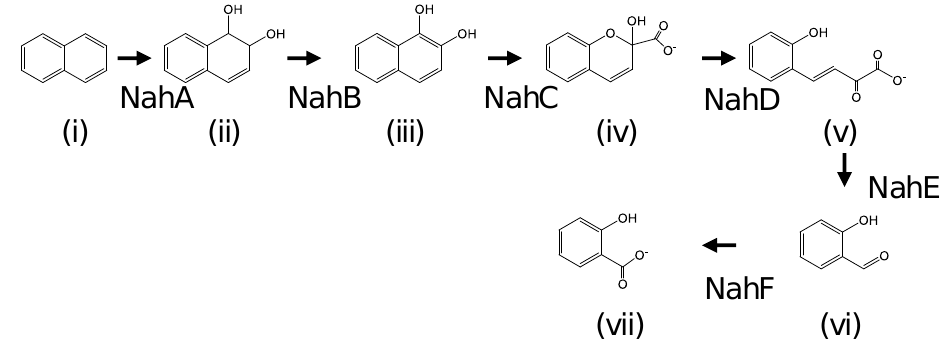
Figure 1. Naphthalene degradation pathway in mesophilic degraders. ( i ) naphthalene, ( ii ) cis -1,2- Dihydroxy-1,2-dihydronaphthalene, ( iii )1,2-dihydroxynaphthalene, ( iv ) 2-hydroxychromene-2- carboxylate, ( v ) trans- o -hydroxybenzylidenepyruvate, ( vi ) salicylaldehyde, ( vii ) salicylate. NahA, naphthalene 1,2-dioxygenase; NahB, 1,2-dihydroxy-1,2-dihydronaphthalene dehydrogenase; NahC, 1,2-dihydroxynaphthalene dioxygenase; NahD, 2-hydroxychromene-2-carboxylate isomerase; NahE, trans - o -hydroxybenzylidenepyruvate hydratase-aldolase; NahF, salicylaldehyde dehydrogenase.